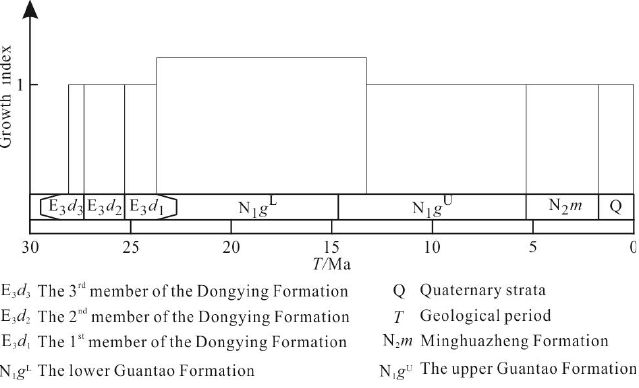
Figure 5. Distribution of the growth index of the F1 Fault in different layers.